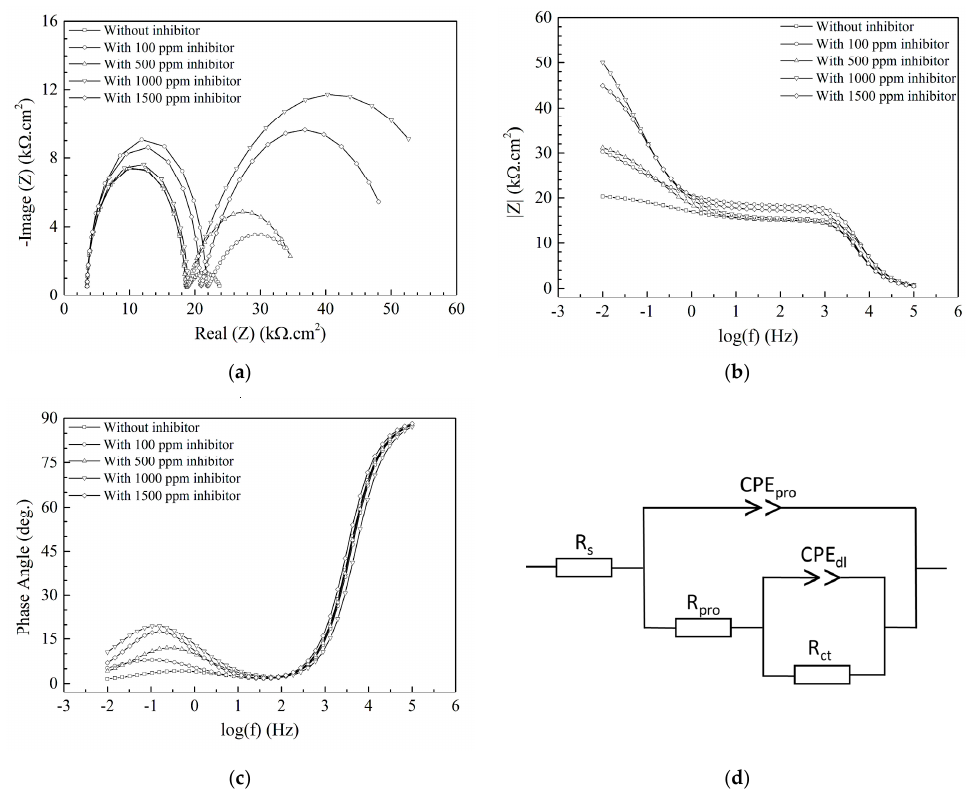
Figure 4. ( a ) Nyquist; Bode plots of ( b ) |Z| versus frequency; and ( c ) phase angle versus frequency of steels after 24-hour immersed in simulated ethanol fuel blend solutions containing different APL-EAE concentrations; and ( d ) equivalent circuit for fitting the impedance